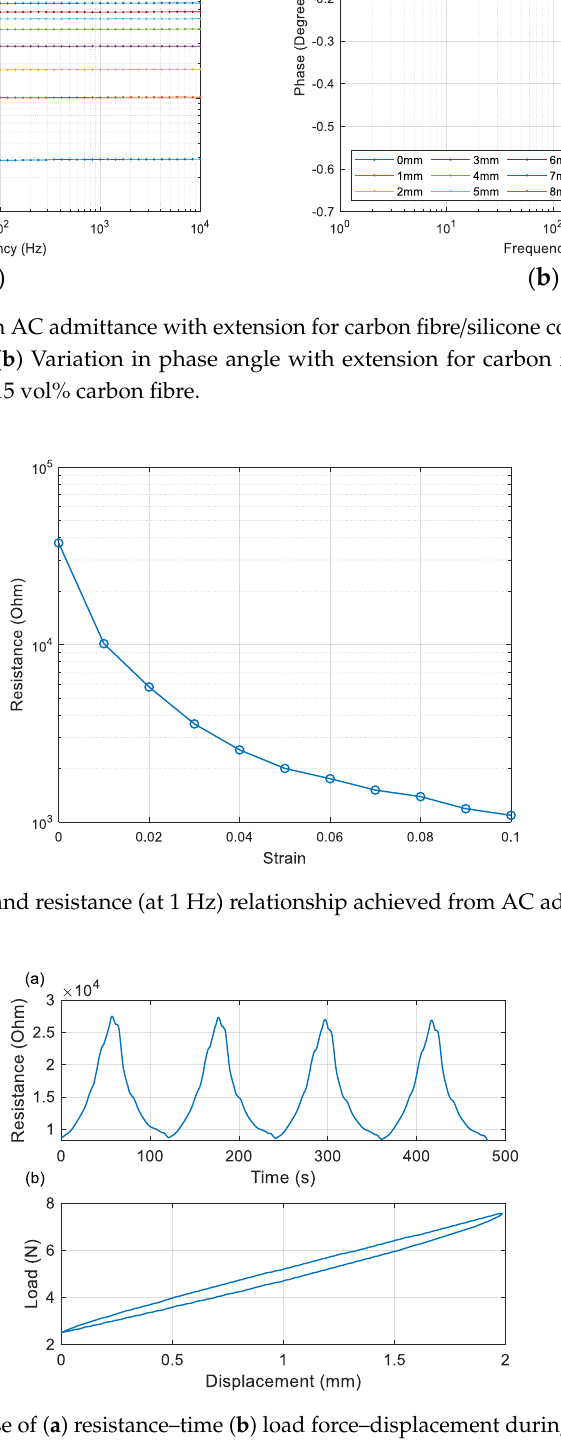
Figure 6. Cyclic response of ( a ) resistance–time ( b ) load force–displacement during cyclic testing of the sensing bottom layer.